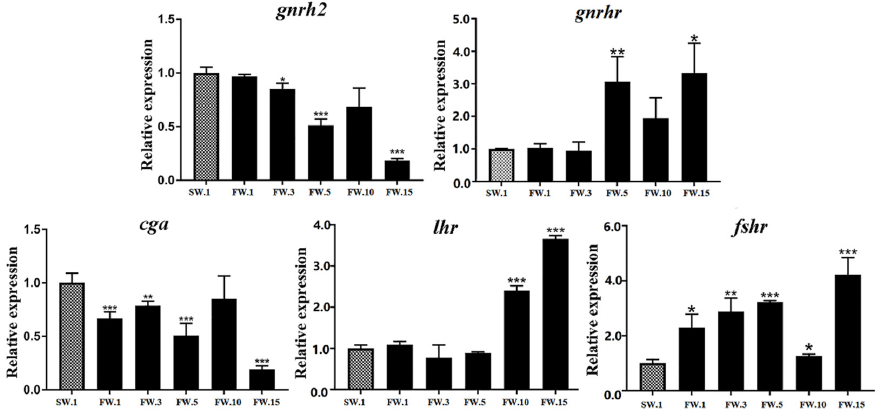
Figure 4. Expression of hypothalamus- and pituitary-related HPG axis genes in the brains of male L. maculatus in response to salinity change. * represents p < 0.05; ** represents p < 0.01; *** represents p < 0.001.